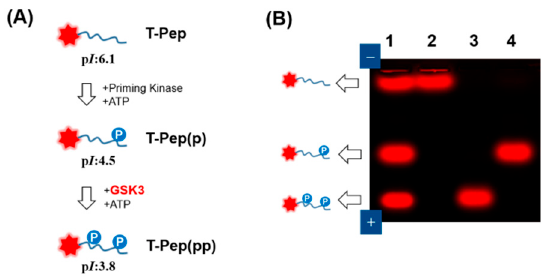
Figure 1. ( A ) Schematic of phosphorylation-induced change in the p I of peptide substrate for GSK3 activity assay. T-Pep, T-Pep(p) and T-Pep(pp) represent TAMRA-KEEPPSPPQSPR, TAMRA-KEEPPSPPQpSPR, and TAMRA-KEEPPpSPPQpSPR, respectively; ( B ) Fluorescent gel image from electrophoretic mobility shift assay of GSK3 activity in a reaction buffer. Lane 1, a control mixture of T-Pep, T-Pep(p), and T-Pep(pp) at a 1:1:1 molar ratio; Lane 2, a mixture of T-Pep and GSK3 with ATP; Lane 3, a mixture of T-Pep(p) and GSK3 with ATP; Lane 4, a mixture of T-Pep(p) and GSK3 without ATP. Each sample was separated on a 1% agarose gel at 50 V for 60 min in 1 × TB. The final concentrations of fluorescent peptide and recombinant active GSK3 were 5 μ M and 1.25 U, respectively. The gel was photographed on a UV transilluminator.